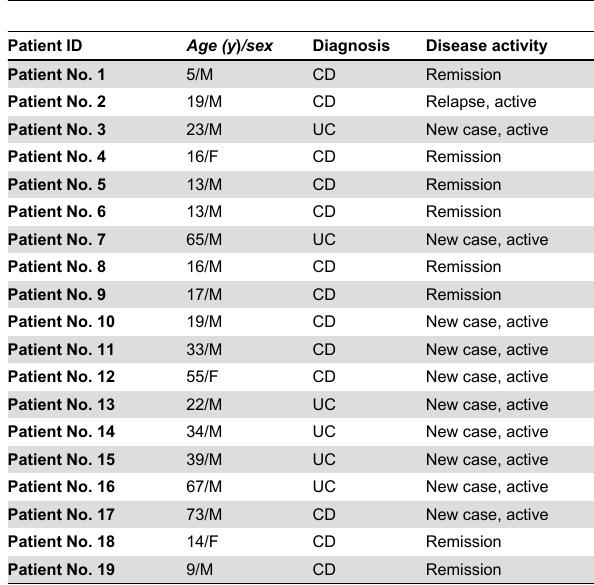
Table 1. Clinical information of patients with IBD included in this